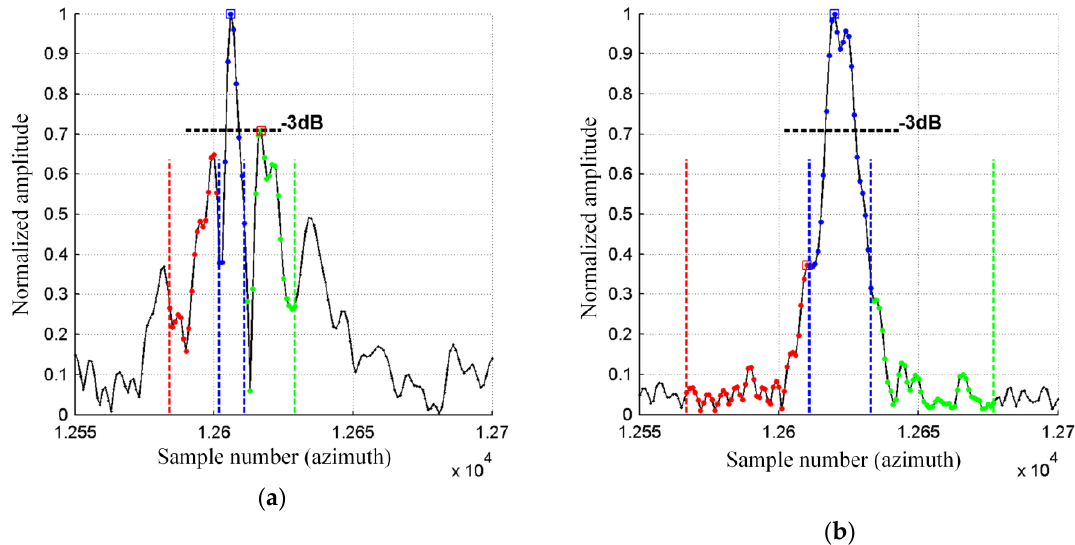
Figure 17. Normalized amplitude of the selected corner reflector image: ( a ) with the INS/GPS-based MOCO, ( b ) with the MINS-based MOCO.